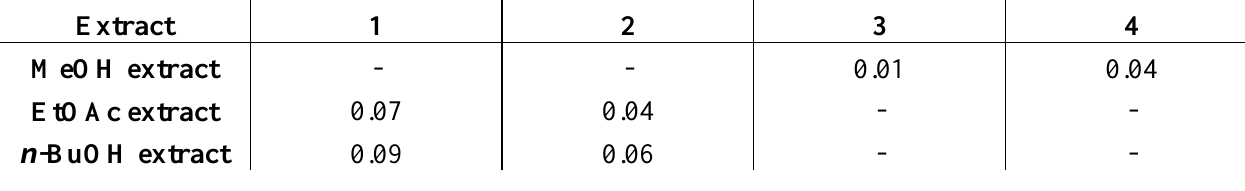
Table 1 : The content of compounds isolated from P. tomentosa fruit in prepared extracts. Data expressed as mols of compound per 100 g dry weight of extract.